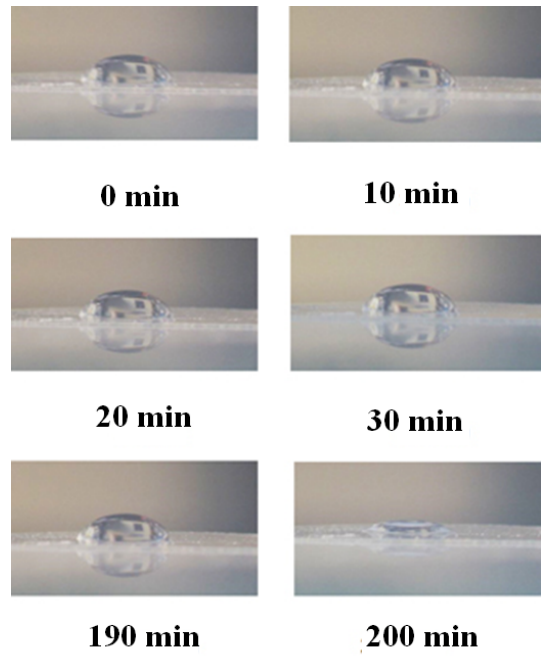
Figure 3. The change of wetting angle of a water droplet on the surface of Nafion membrane vs. the time of soaking the membrane in water. The photo was taken by one of authors.